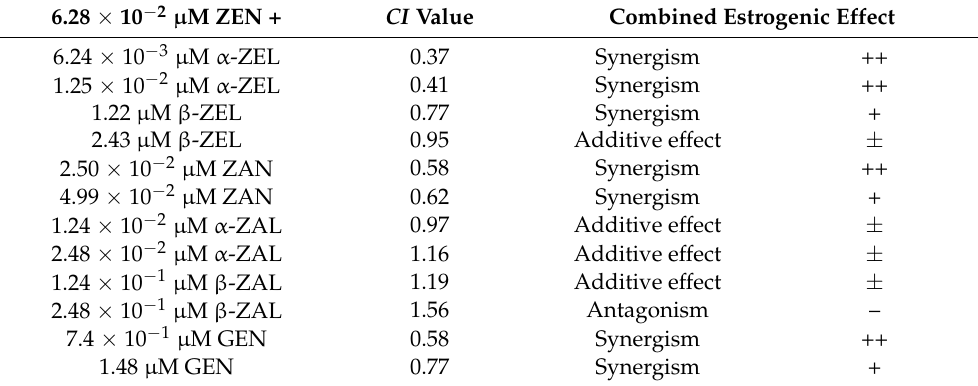
Table 2. The combination index values ( CI < 0.8: synergism; 0.8 < CI < 1.2: additive effect; and CI > 1.2: antagonism), and combined estrogenic effects of ZEN with ZELs, ZAN, ZALs, and